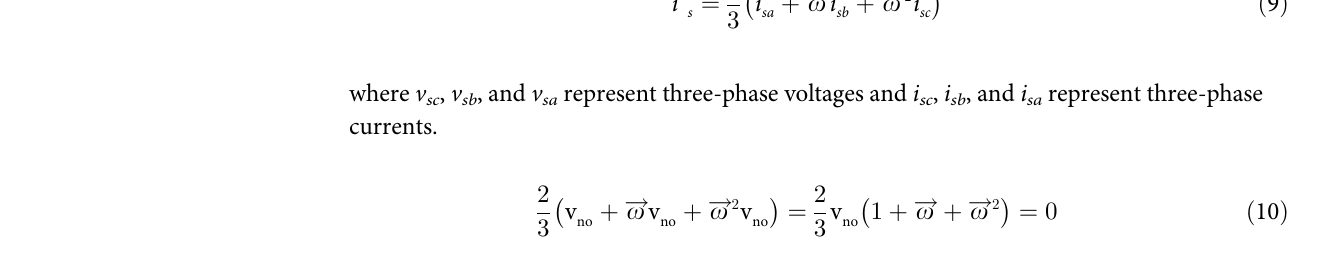
, i , and i represent three-phase sc sb sa